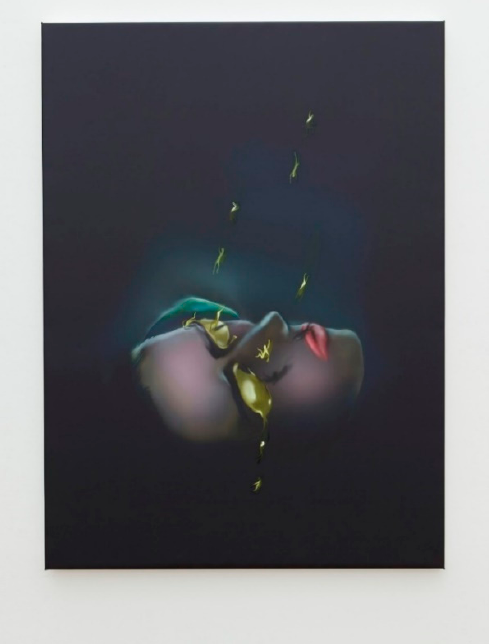
Figure 2. Louisa Gagliardi. Under the Weather, 2087. Gel medium, ink on PVC. Photo courtesy of Dewi Lloyd.